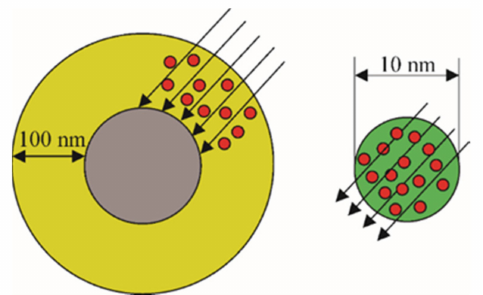
Figure 2. Light absorption by micro- and nanoparticles of TiO 2